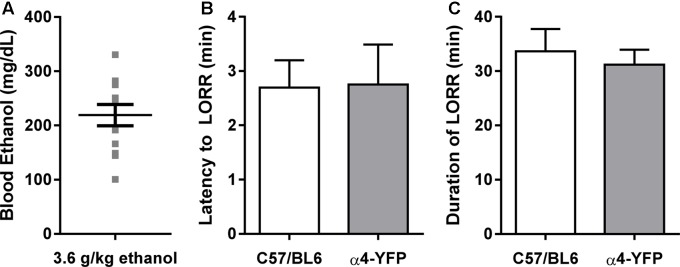
Sensitivity to ethanol in α4-YFP-KI mice. (A) Blood ethanol concentrations following a single sedating dose of ethanol. Data are presented as mean ethanol concentration in mg per dL ± SEM. (B,C) The latency to, and duration of the sedative effects of ethanol show no differences between C57Bl6 and α4-YFP mice. Data are presented as mean latency to LORR in min ± SEM (B), and duration of LORR in min ± SEM (C); p = 0.95 and p = 0.63, respectively.